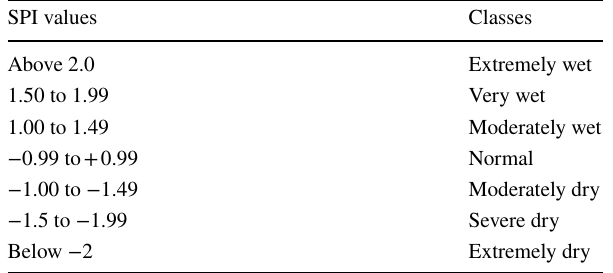
Table 1 Drought type classification table based on SPI values SPI values Classes Above